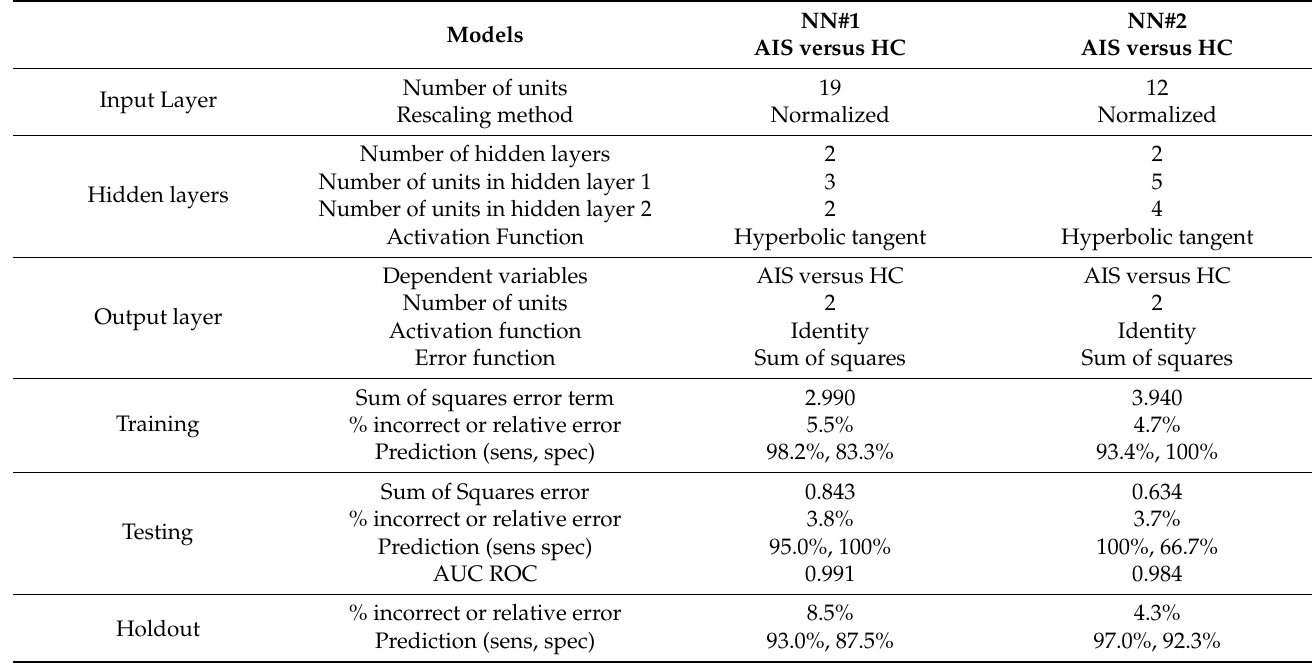
Table 3. Results of two neural networks with acute ischemic stroke (AIS) versus healthy controls (HC) as output variables and oxidative stress and antioxidant biomarkers and clinical data as in- put variables.